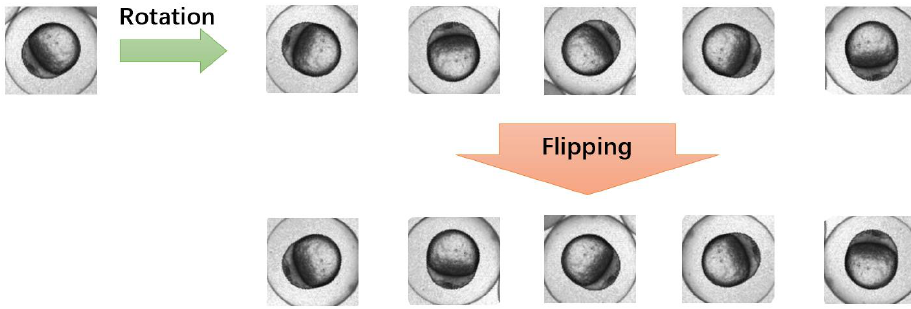
Figure 4. Examples of the one zebrafish egg (the leftmost patch) and its augmented patches, including rotational augmentation and flipping augmentation.